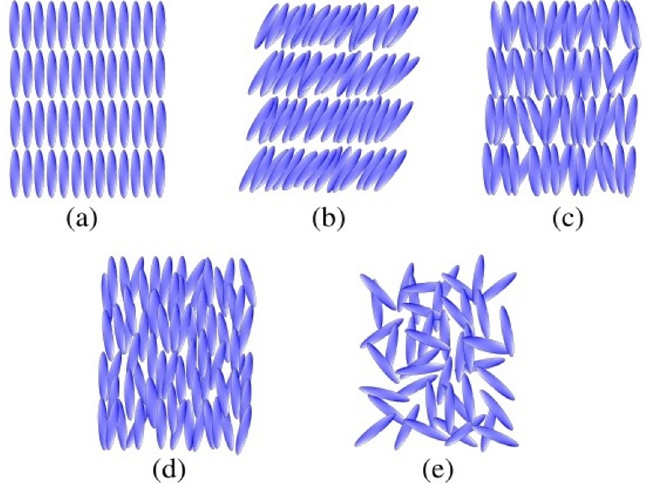
Figure 1 . The (cid:12)gure above depicts the microscopic appearance of various phases of liquid crystal in order from lowest to highest temperature. The phases are (a) crystalline solid, (b) smectic liquid crystal in phase C, (c) smectic liquid crystal in phase A, (d) nematic liquid crystal, and (e) isotropic, i.e. (cid:13)uid phase. Notice that (a) spontaneously breaks the most symmetries and each subsequent phase spontaneously breaks fewer and few symmetries until (e) only breaks